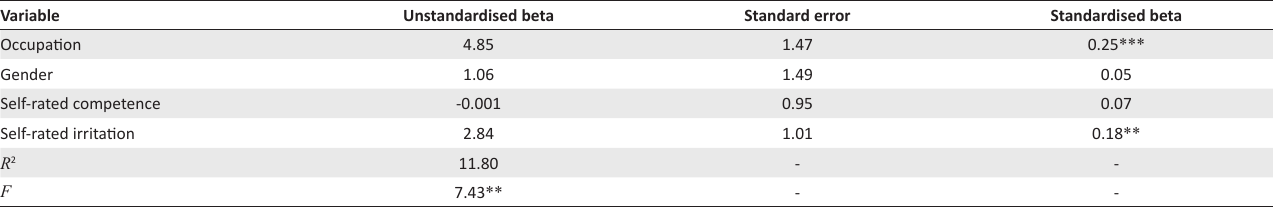
TABLE 8: Multiple regression analysis for variables predicting attitudes toward suicidal behaviour as measured by the validated Attitudes Toward Suicide Scale. Variable